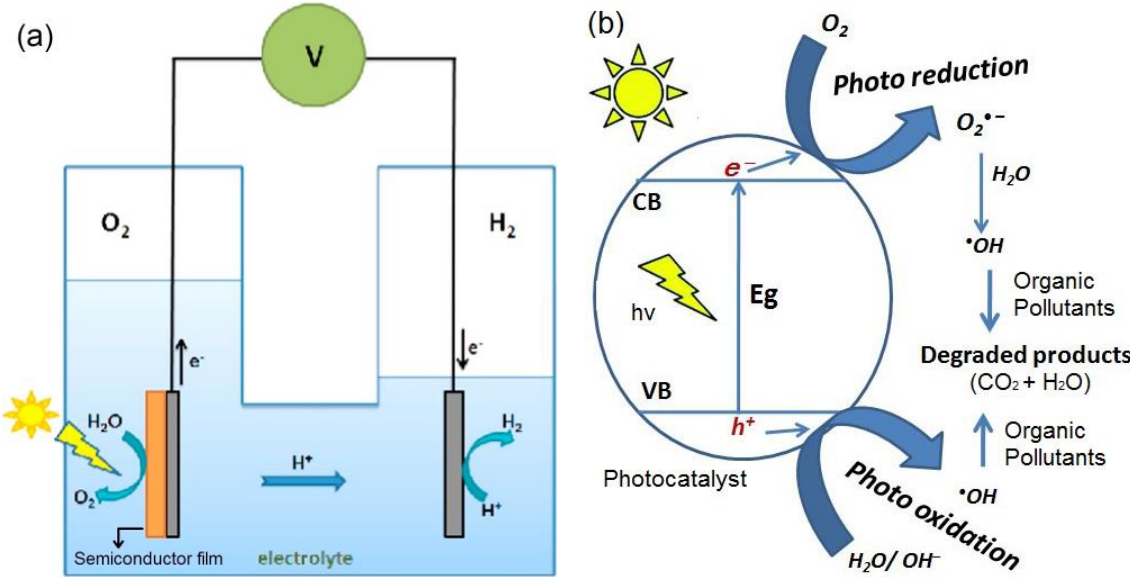
Figure 1. (a) Honda and Fujishima water splitting scheme for hydrogen evolution [4]; and (b) Photocatalysis wastewater treatment process. Adapted from Kumar et al., (2017) [5]